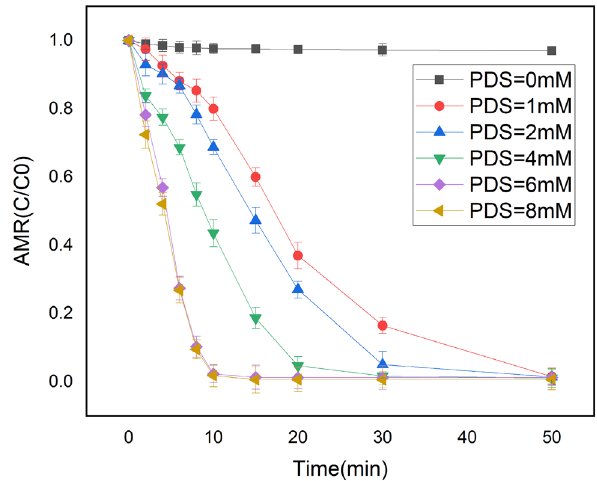
Fig. 1 Effect of PDS concentration on AMR degradation in persul- fate–ZVI system. Change of the persulfate concentration over